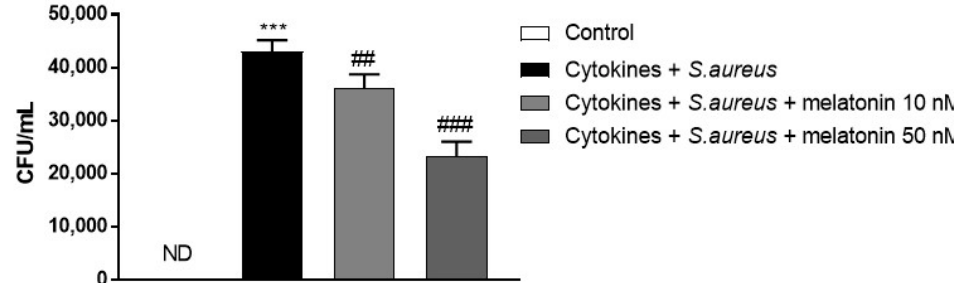
Figure 2. Effect of melatonin on CFU evaluation after S. aureus infection. The figure shows that S. aureus adherence was high in the S. aureus -associated psoriasis group compared to control (ND = not detected); however, melatonin treatment at 10 nM and 50 nM significantly reduced it. *** p < 0.001 vs. CTR; ## p < 0.01 vs. cytokines+ S. aureus group. ### p < 0.001 vs. cytokines + S. aureus group.